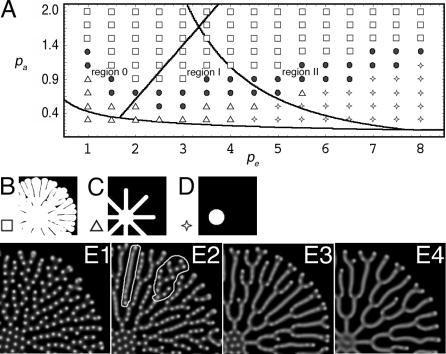
Parameter-Dependency of the Pattern Formation(A–D) Searches for parameter values for dendritic branch formation on a (pe − pa)-plane. The fixed parameters were pb = 0.8, d = 30.0, ph = 1.0, Tr = 1.0, A
max = 30.0, R = 0.004, and γ = 625. Total calculation time was 4 × 105 steps.(A) Closed circle: dendritic pattern; square: wide branches; triangle: no second-order branching; and star: no growth. Examples of non-dendritic patterns of square, triangle, and star are shown in (B) (pa = 2.1 and pe = 8.0), (C) pa = 0.5 and pe = 4.0), and (D) (D (pa = 0.7 and pe = 6.5), respectively. Region I satisfies conditions of Turing diffusion-induced instability described by Equations 6a–6d, whereas region II satisfies Equations 6a–6c, but not Equation 6d and region 0 satisfies Equations 6b–6d, but not Equation 6a. In region I, spatially periodic patterns appear in a conventional RD model, whereas homogenous patterns are stable in region II.(E1–E4) Distributions of the activator that were obtained at different coordinates in the phase diagram (A). pa = 0.7 for all panels; and pe = 3.0 (E1), 3.5 (E2), 4.0 (E3), and 4.5 (E4). The distribution of the activator changes from a punctate pattern (E1) to a more continuous pattern (E4).(E2) A punctate distribution of the activator in a branch-rich region (enclosed area at right) and a more continuous one in a branch-less region (enclosed area at left).